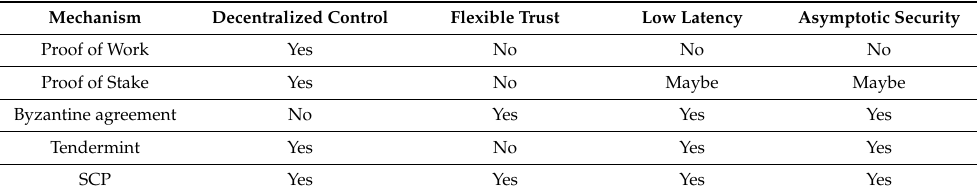
Table 2. Properties of different consensus mechanisms